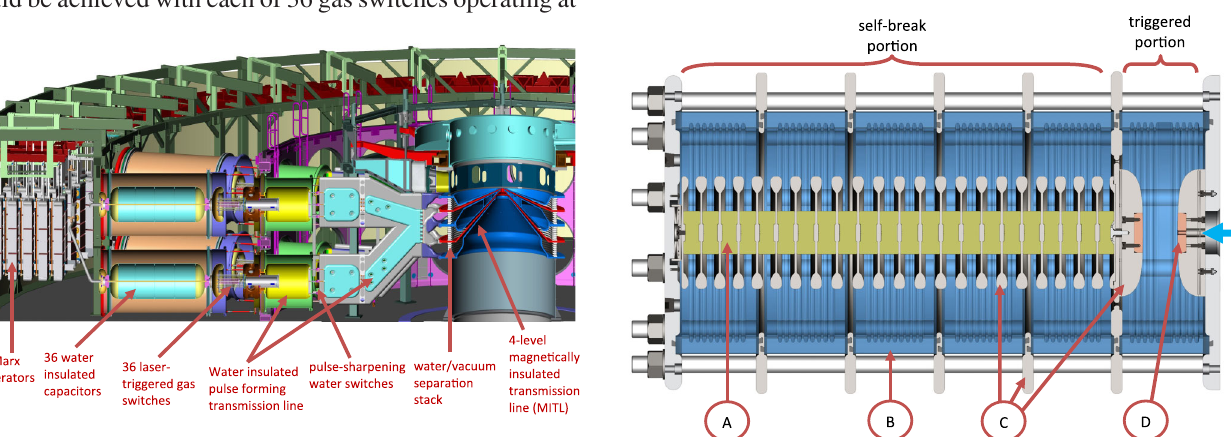
FIG. 2. (Color) Cross section of the 6.1-MV LTGS for the refurbished Z accelerator. The switch is cylindrically symmetric about the laser beam entry path (large blue arrow on the right side). Material: (A) slurry cast polymethyl methacrylate (acrylic), (B) monomer cast acrylic manufactured by C-Lec Plastics, (C) stainless steel 304, (D) 10% infiltrated copper, 90% tungsten particulate that is (cid:1) 3 (cid:1) m in size called Elkonite